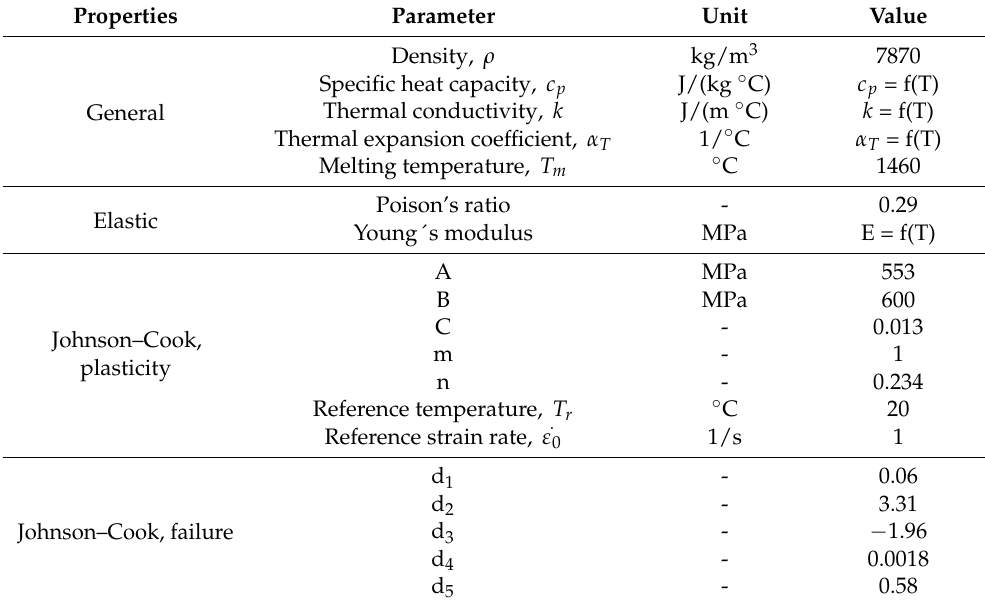
Table 1. Material data of AISI 1045